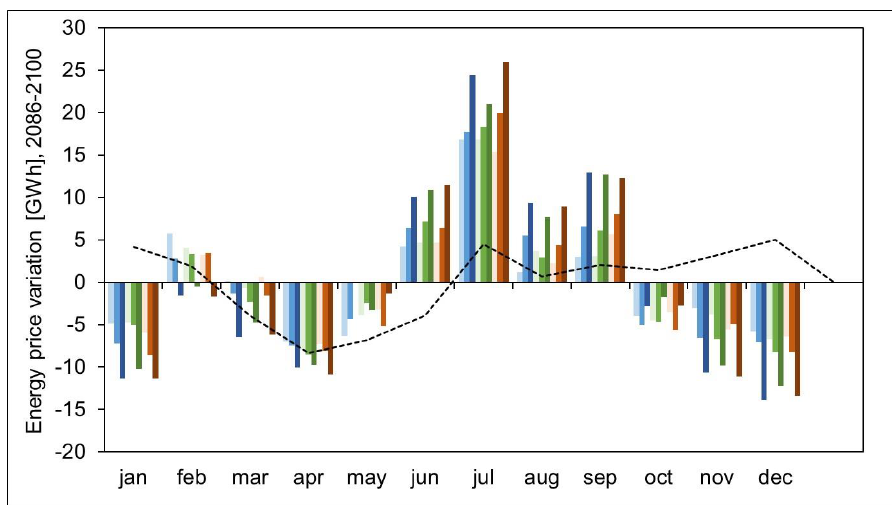
Figure 11. Sabbione reservoir. Projected mean monthly energy price relative to annual mean (€/MWh), against the CR scenario for period P1 (2045–2059).